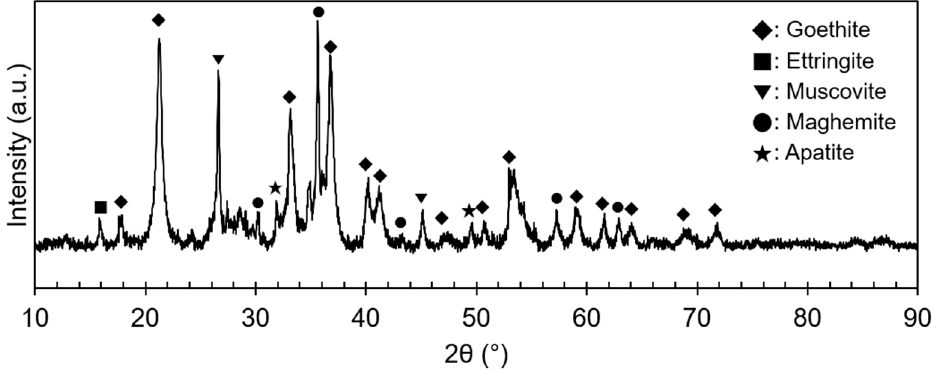
Figure 1. XRD pattern of the REE ore.